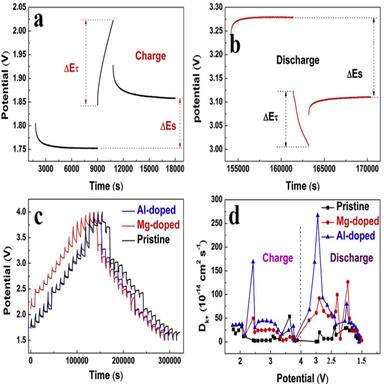
Schematics of GITT technique in (a) charge and (b) discharge process. (c) GITT potential profiles in KIBs during the third cycle and (d) Kþ diffusion coefficients calculated from the GITT results for the pristine, Mg-doped and Al-doped electrodes.